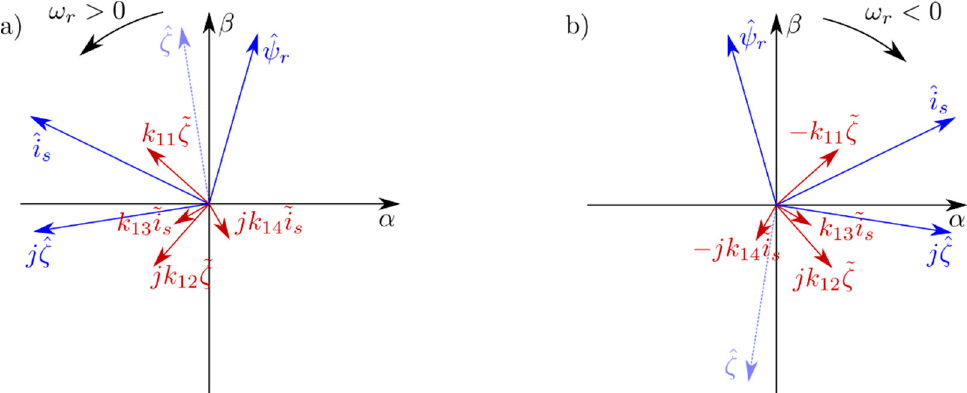
rotation direction change, it may be possible for the observer properties to remain in symmetry.